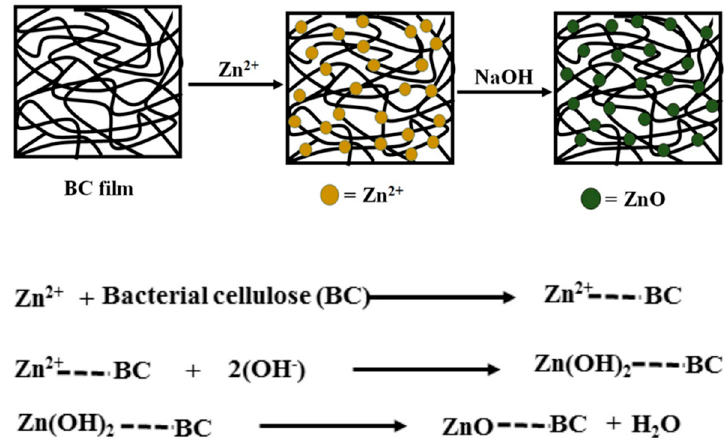
Figure 3. The mechanism proposed for the formation of ZnO NPs inside the BC network [59].